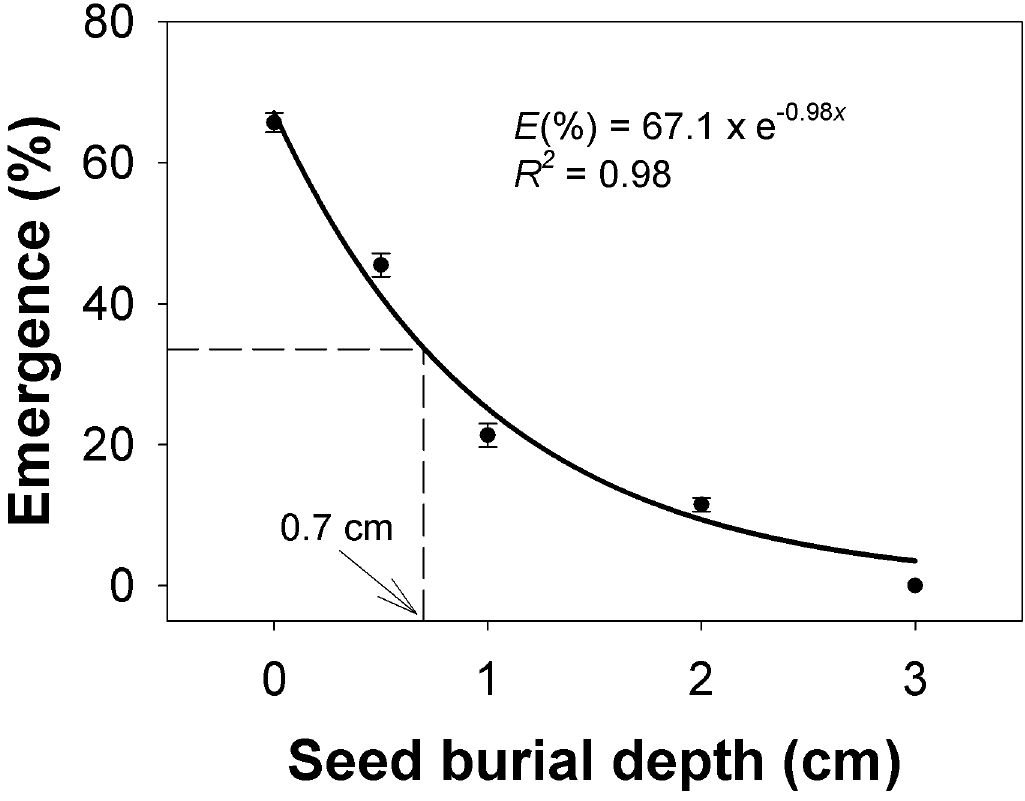
Fig 5. Effect of seed burial depth on seedling emergence of Chloristruncata after 21 d of incubation at 25/15˚C day/night temperature. The line represents an exponential decay model fitted to the data. The arrow shows the seed burial depth required to inhibit 50% emergence. Vertical bars represent standard error of